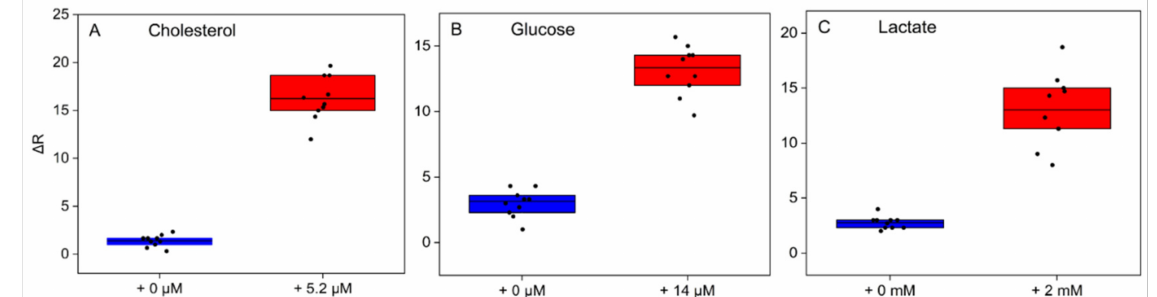
Figure 2. ∆ R values of the detection zones collected at the end of the assay (10 min) performed on native saliva (blue bars) and saliva spiked with ( A ) 5.2 µ M cholesterol, ( B ) 14 µ M glucose and ( C ) 2 mM lactate (red bars). Graphs provide the average result of 10 assays performed on saliva collected from 10 different